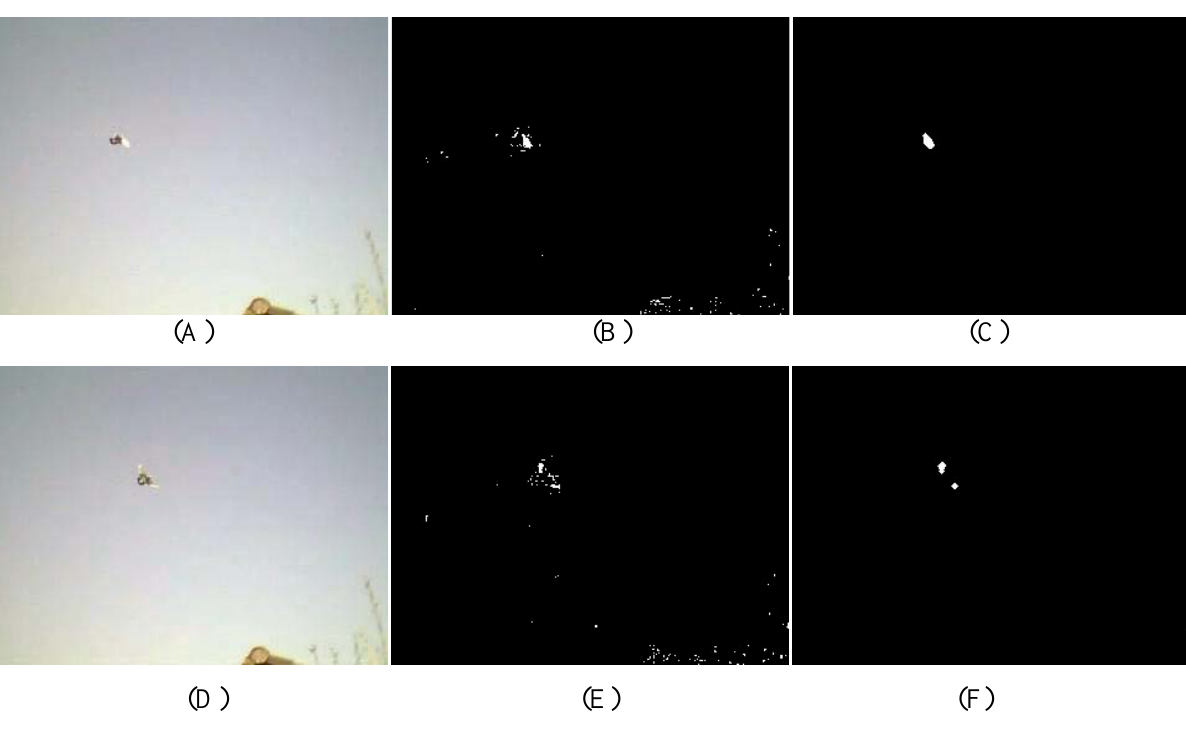
Figure 13. Processing example of two succeeding frames of a webcam recording a flying pigeon. (A) and (D) show the full color image; (B) and (E) the outcome of the median filter, and (C) and (F) after processing to reduce noise and to connect foreground pixels to a number of adjacent foreground pixels. Due to wing flap, two objects emerge.